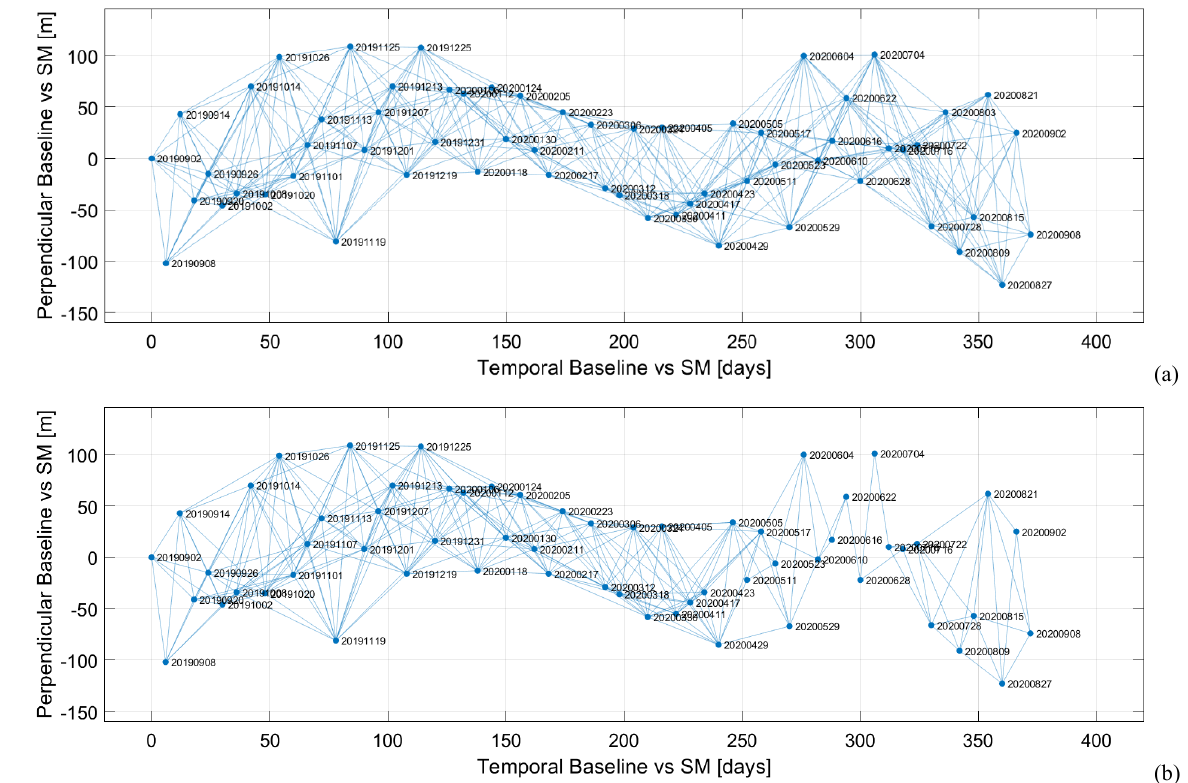
Figure 2 Small baseline interferogram network, full (a) and reduced (b) for Sentinel-1 ascending data, represented in the plane given by the temporal/perpendicular baselines with respect to the Super-Master image.